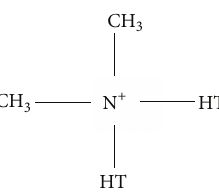
Figure 2: Molecular structure of Cloisite 15A [17].